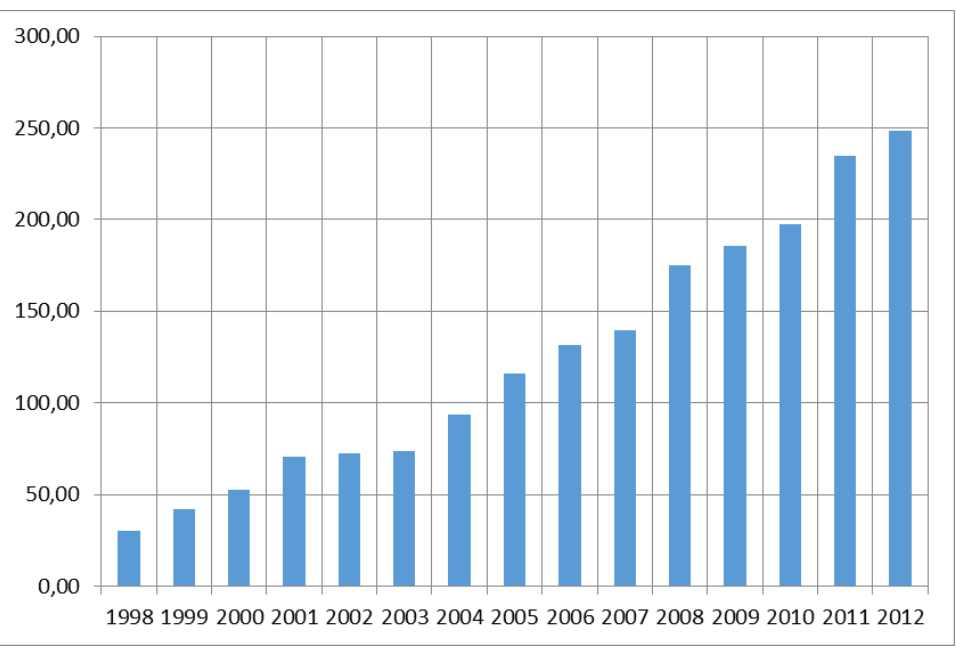
Figure 7: Electricity flat-rate average tariffs (RUB for 100 KWh) in Russia in 1998-2012 Table 5: Results of research for impact of RIS development level indicators (average for 2008-2009) on intensity of the innovative process in increasing energy efficiency Independent variable Number of F -calculated F -critical p -level Independent variable groups Internal R&D